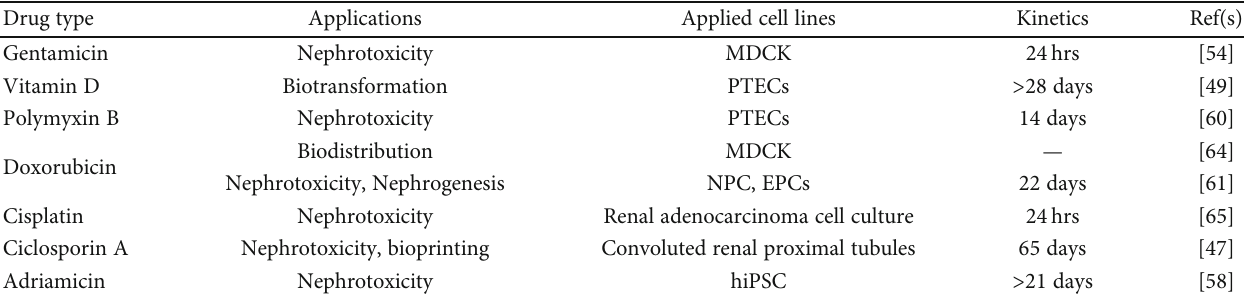
Table 2: Summary of recent advancements of kidney-on-a-chip devices including the type of drug, the application, the applied cell, and the